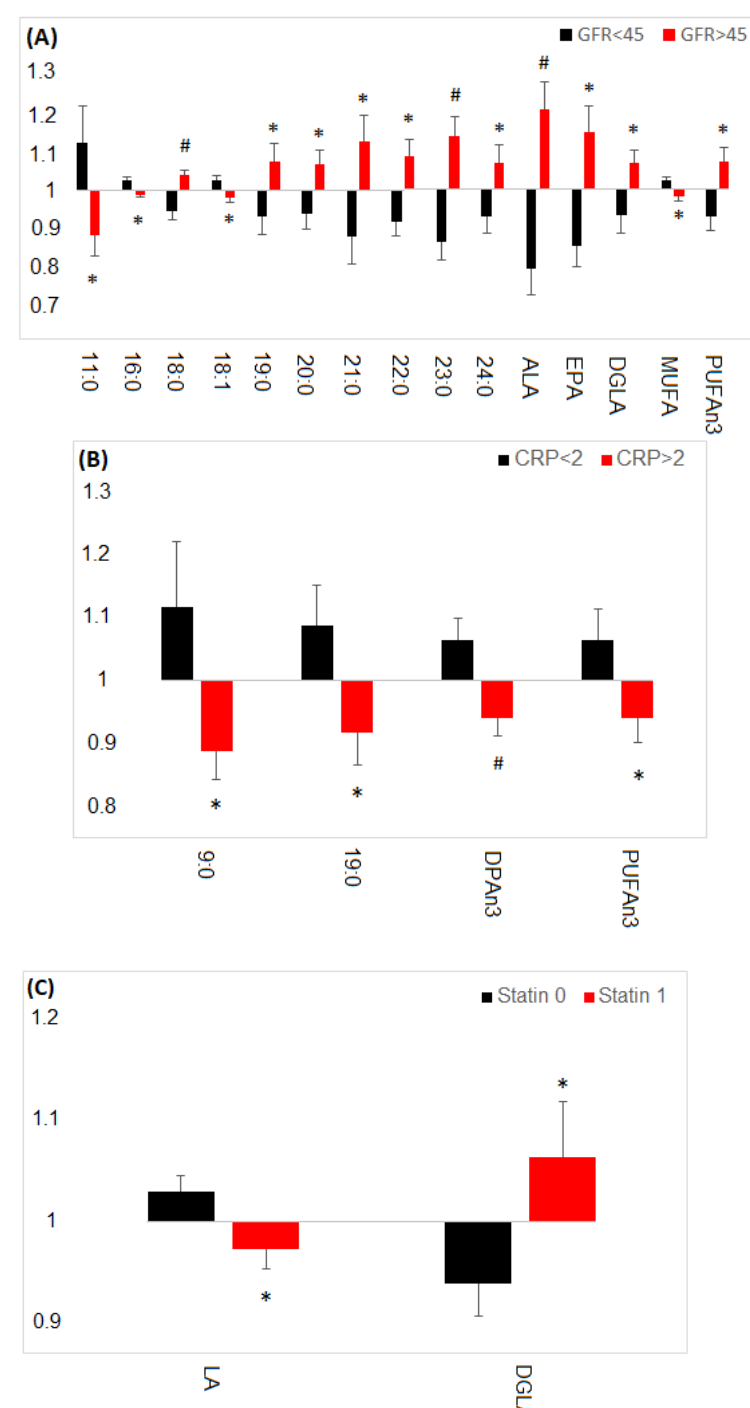
Figure 5. Normalized FA changes in different subgroups of Tx patients ( A ) With glomerular filtration rate below and above 45; ( B ) With c-reactive protein below and above; ( C ) Using (Statin 1) or no using statins (Statin 0). Data are presented as mean ± SEM. * p < 0.05; # p < 0.001 indicates statistically significant difference compared to controls. ALA- α -linolenic acid; DGLA-dihomo- γ -linolenic acid; DPA n3-docosapentaenoic acid n3; EPA-eicosapentaenoic acid; LA-linoleic acid; MUFA-monounsaturated fatty acids; PUFA-polyunsaturated fatty acids.